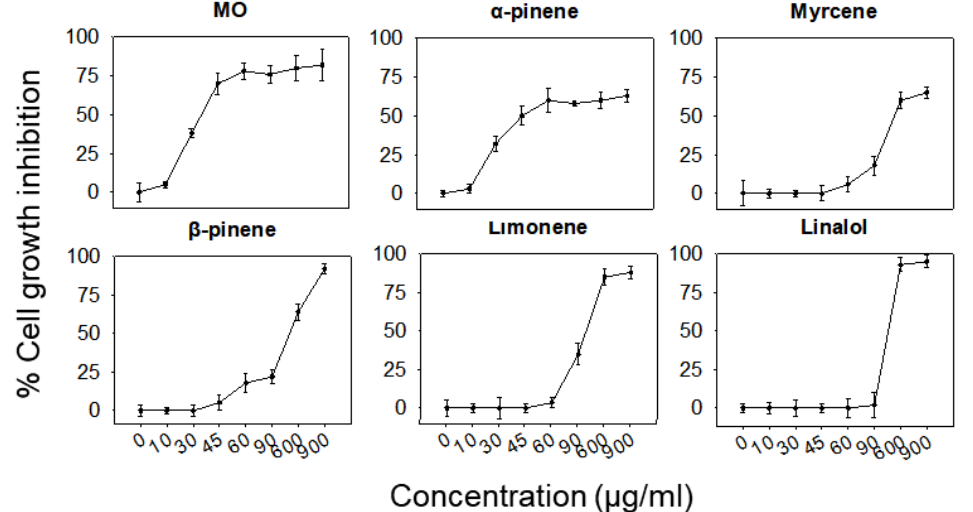
Figure 3. Effect of MO or its major constituents on the growth rate of RAW264.7 cells after 24 h of treatment. Cell growth inhibition was analysed using the SRB assay. Values represent means ± SD of at least four replicates. Data shown are representative of three independent experiments.